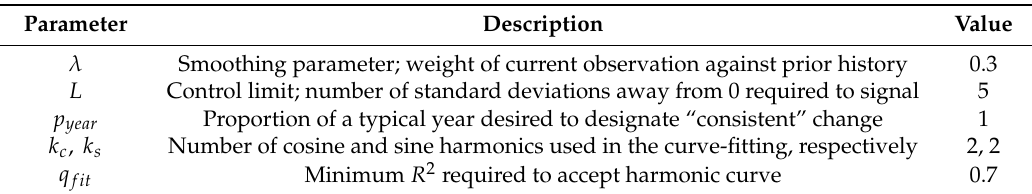
Table 1. Selected parameters for Edyn/EWMACD used in this study. Parameter Description